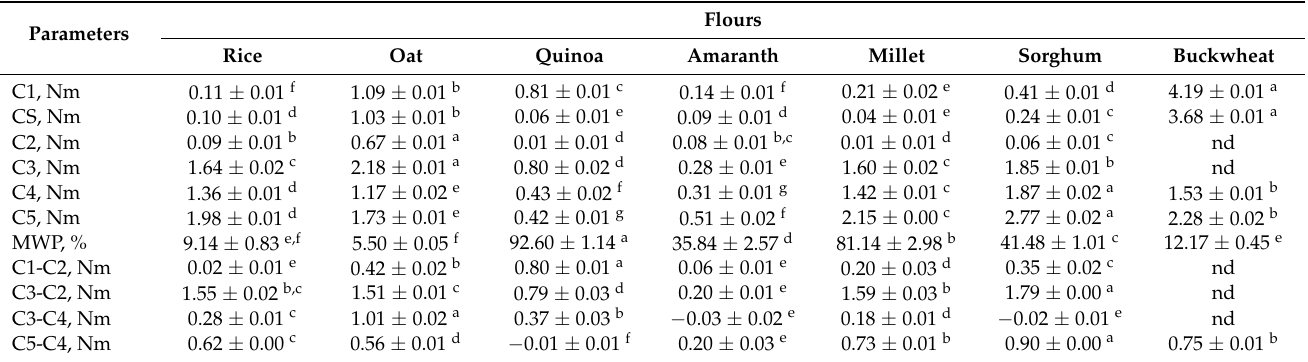
Table 4. The thermo-mechanical properties of gluten-free flours at a water absorption of 85% used for obtaining